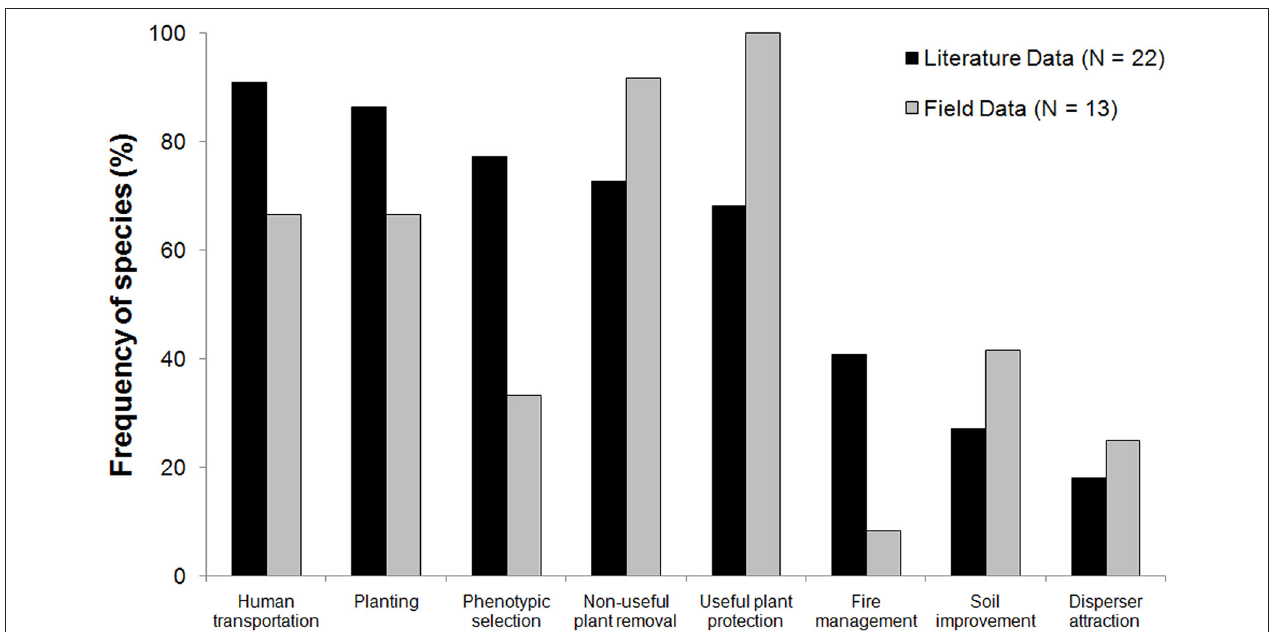
FIGURE 2 | Frequency of useful species involved in each management practice based on the literature (black bars) and field interviews (gray bars). Information for 22 species was obtained from the literature and for 13 species in the field in two